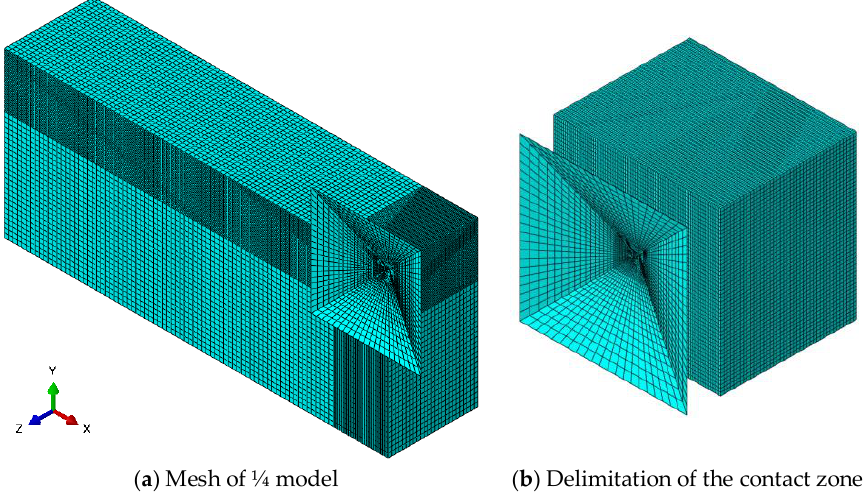
Figure 17. 3D Finite element model for indentation test simulation.